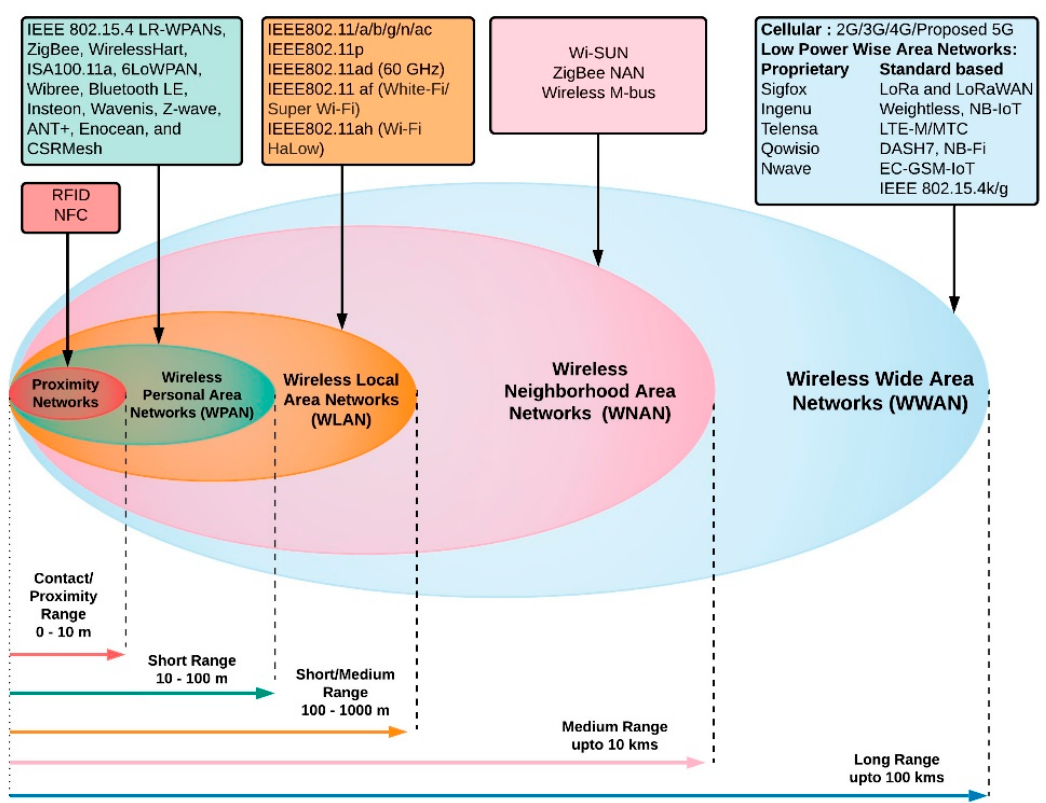
Figure 2. Wireless access geographic coverage. RFID, radio frequency identification; NFC, near field communication; NB-IoT, Narrowband Internet of Things; LTE, long term evolution; GSM, global system for mobile communications; MTC, machine type communication; SUN, smart utility network; LE, low energy.